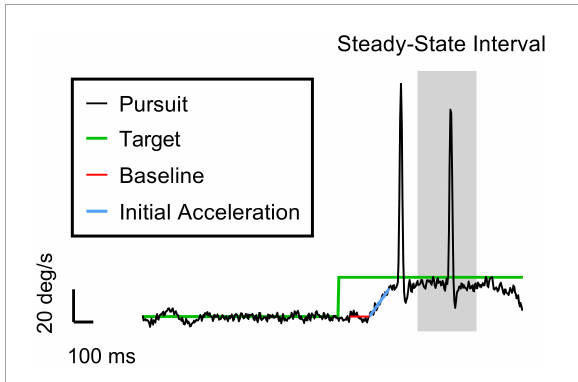
FIGURE1 An example trial of the ocular tracking response in our task. The vertical and horizontal axes are velocity and time, respectively. The black and green traces are the eye and target velocities (20 deg/s target speed for this trial), respectively. The red and blue lines represent the best hinge fit, where the breakpoint indicates the pursuit latency when the eye starts to accelerate. The slope of the blue line gives the initial acceleration of the eye. The grey region is the 300-ms interval of time in which we calculate the closed-loop pursuit gain and the saccade metrics (i.e., rate and amplitude). We chose 400–700 ms as the steady-state (SS) interval to isolate these catch-up saccades from both tracking initiation and any potential behavioral disengagement due to anticipation of the end of the trial. Note the initial clean smooth initiation typical of the Rashbass design. The first saccade in the trace was a late initial corrective saccade related primarily to the imperfect smooth initiation. The second saccade is deemed a true steady-state catch-up saccade since it occurred during the steady-state interval, suggesting that the saccade was closely related to the sustained suboptimal closed-loop steady-state pursuit gain ( <